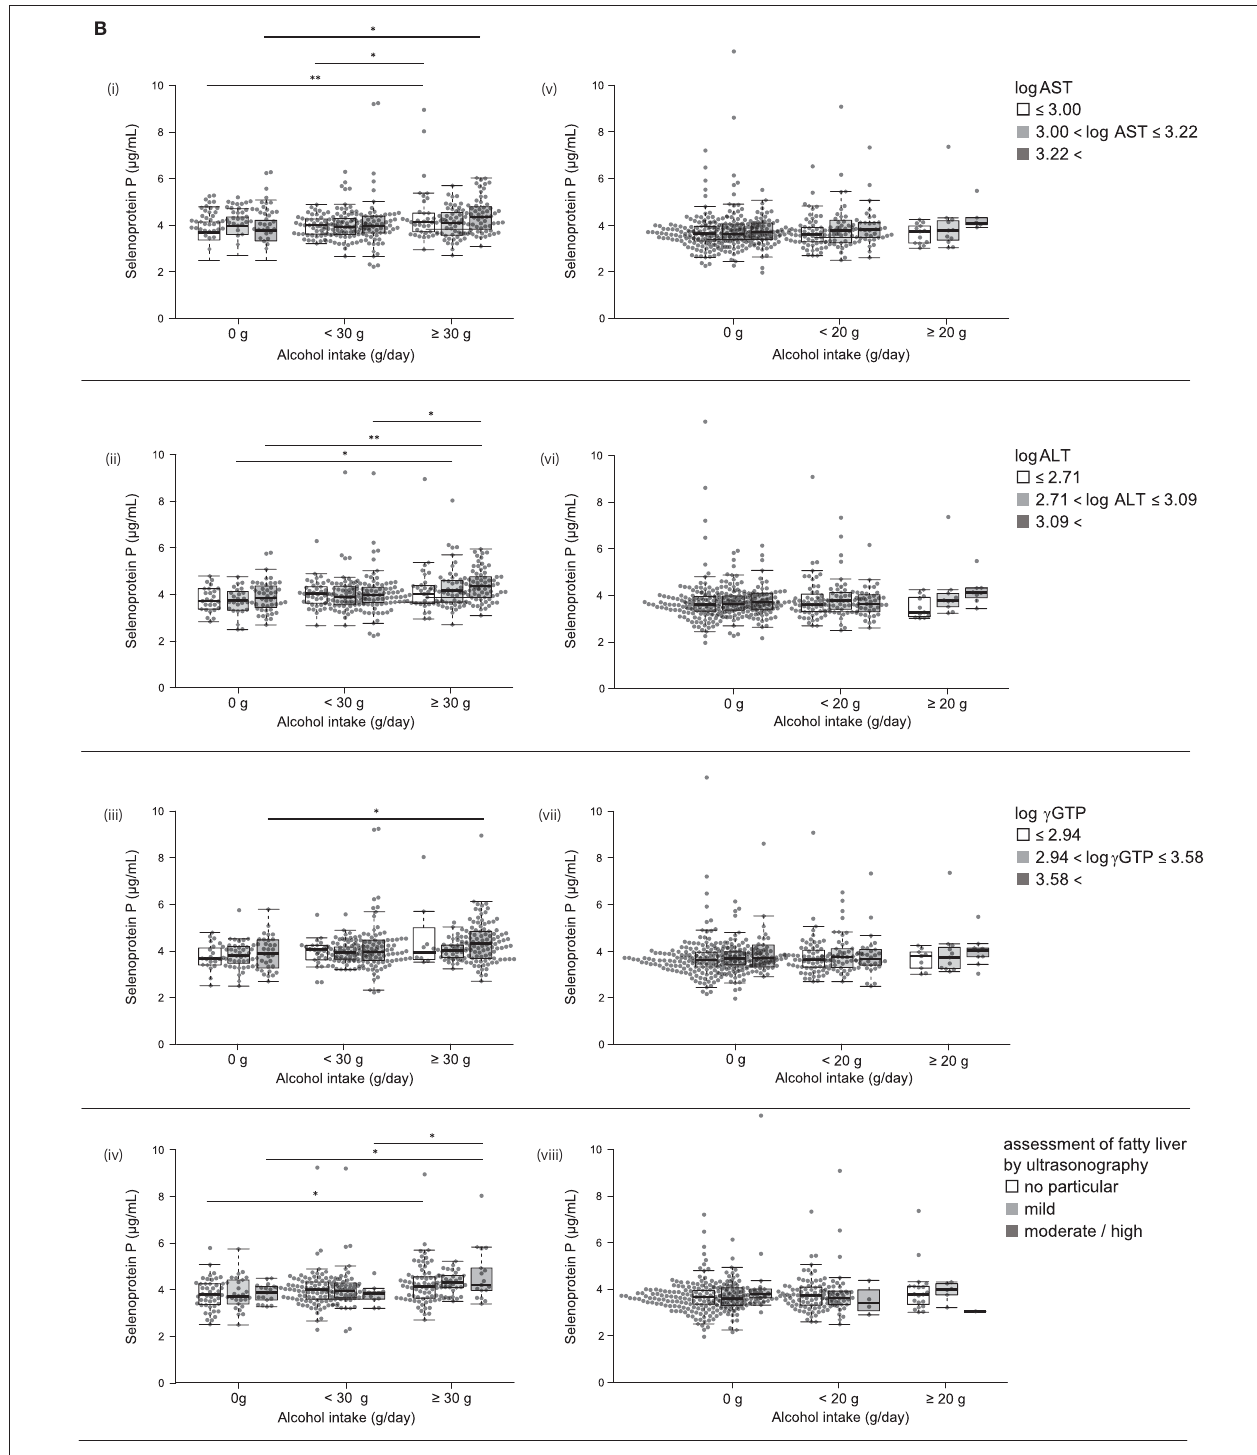
FIGURE 2 | (A) Serum levels of selenium and selenoprotein P in participants with different alcohol intake levels and different liver enzyme levels. Serum levels of selenium in participants according to various levels of log AST (i,v), log ALT (ii,vi), log γ GTP (iii,vii), and fatty liver by ultrasonography (iv,viii) in men (i ∼ iv) and women (v ∼ viii). (B) Serum levels of selenoprotein P in participants with different alcohol intake levels and different liver enzyme levels. Serum levels of selenoprotein P in participants according to various levels of log AST (i,v), log ALT (ii,vi), log γ GTP (iii,vii), and fatty liver by ultrasonography (iv,viii) in men (i ∼ iv) and women (v ∼ viii). In box-plots, center lines show the medians, and box limits indicate the 25th and 75th percentiles; whiskers extend 1.5x the interquartile range from the 25th and 75th percentiles; data points are plotted as dots. * p < 0.05; ** p < 0.01.